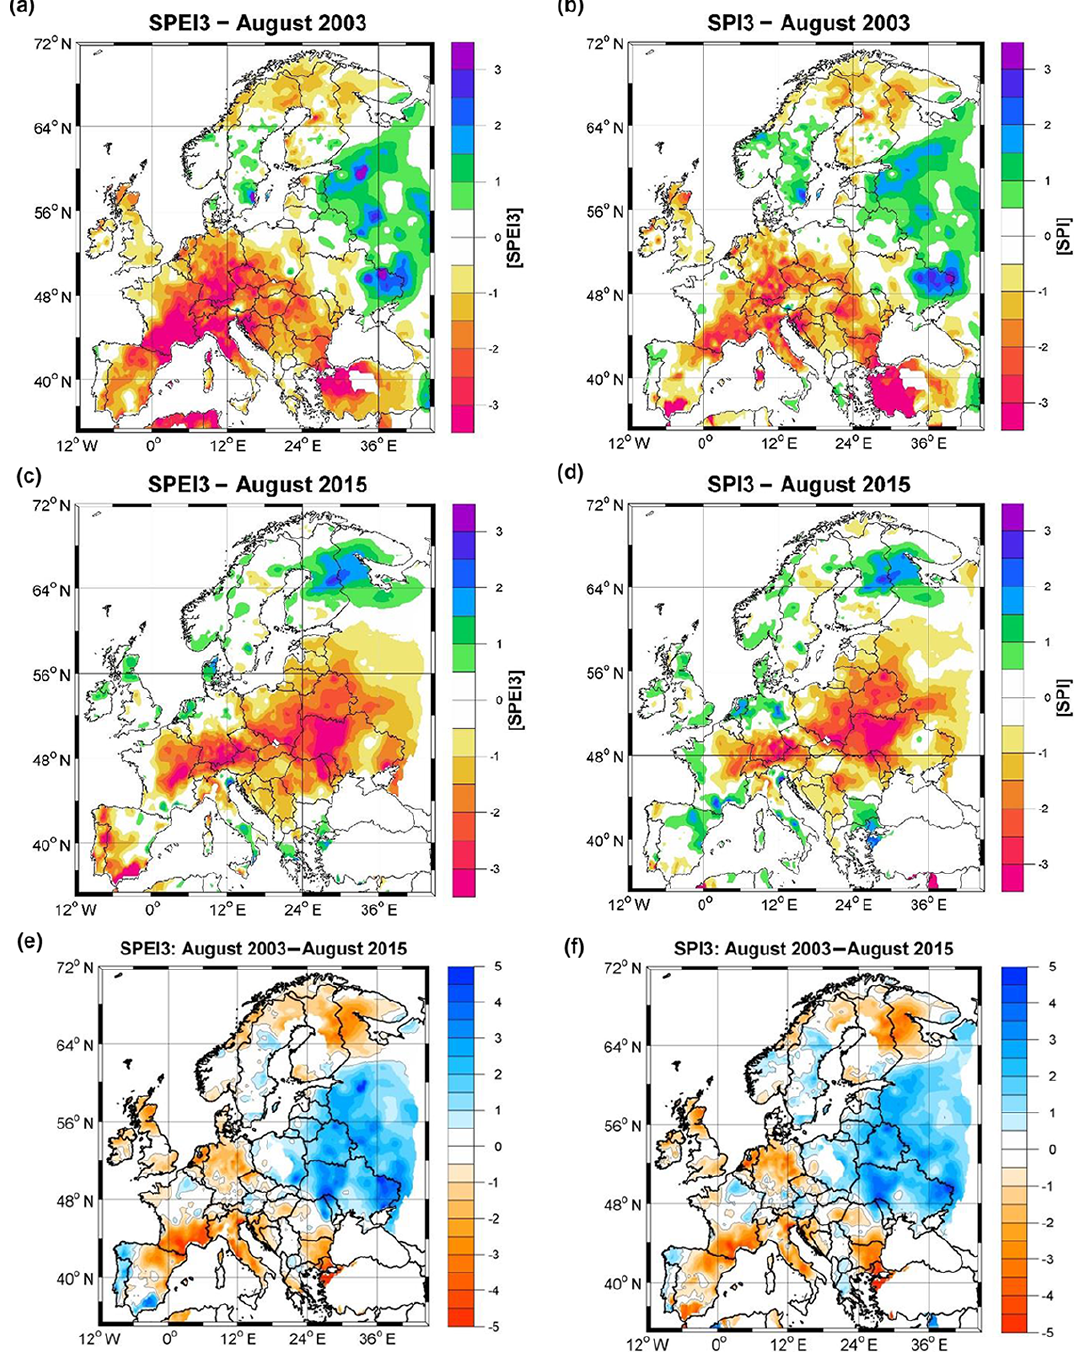
Figure 8. (a) August 2003 SPEI3; (b) as in (a) but for SPI3. (c) August 2015 SPEI3; (d) as in (c) but for SPI3. (e) The difference between August 2003 SPEI3 and August 2015 SPEI3; (f) as in (e) but for SPI3.